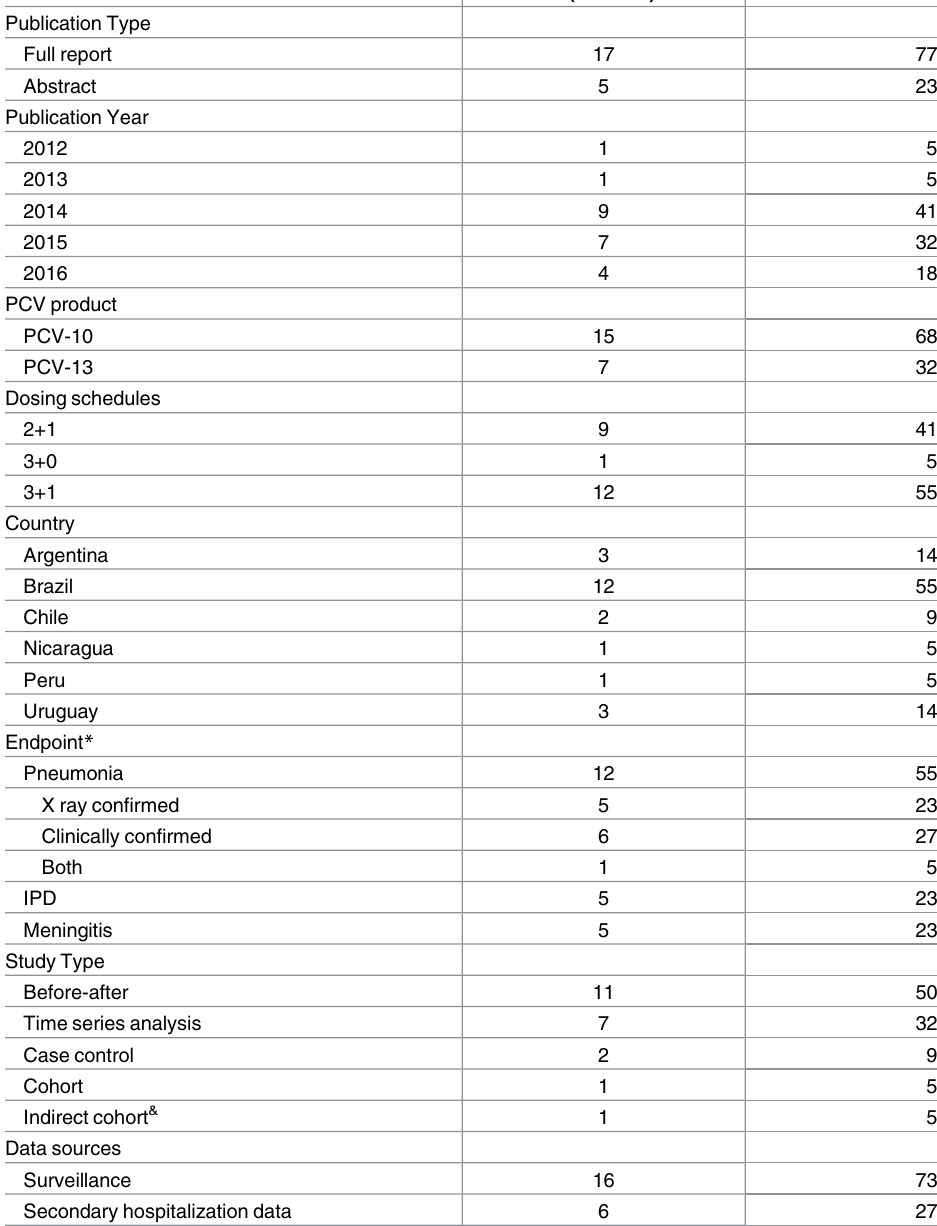
Table 1. Summary of characteristics from 22 included studies.